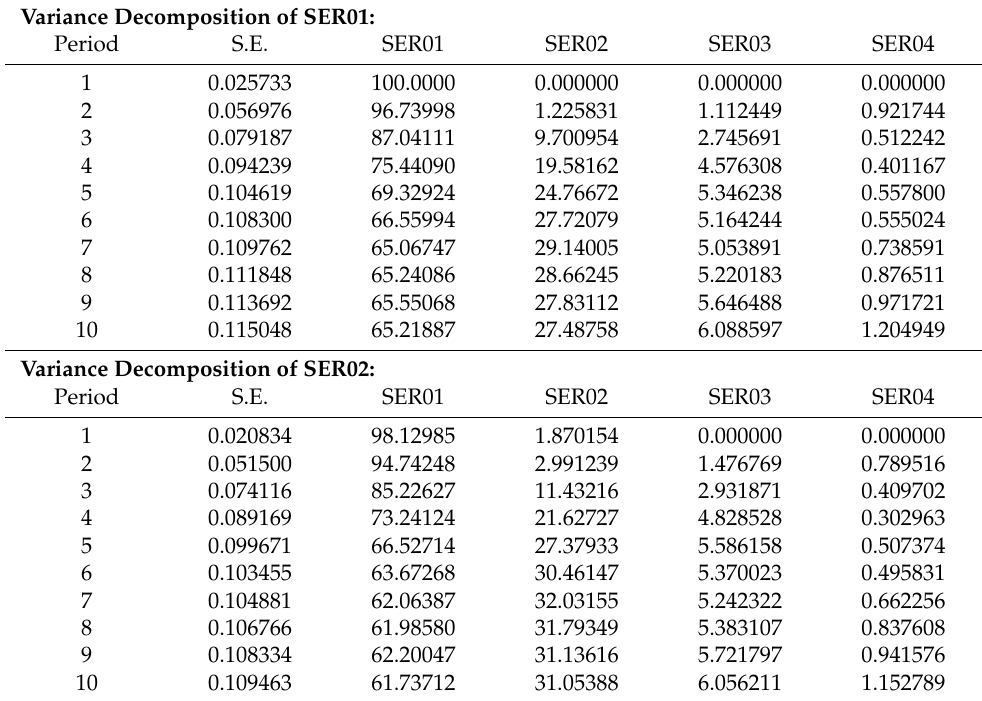
Table 7. The variance decomposition of the changes of each endogenous variable in the VAR model.